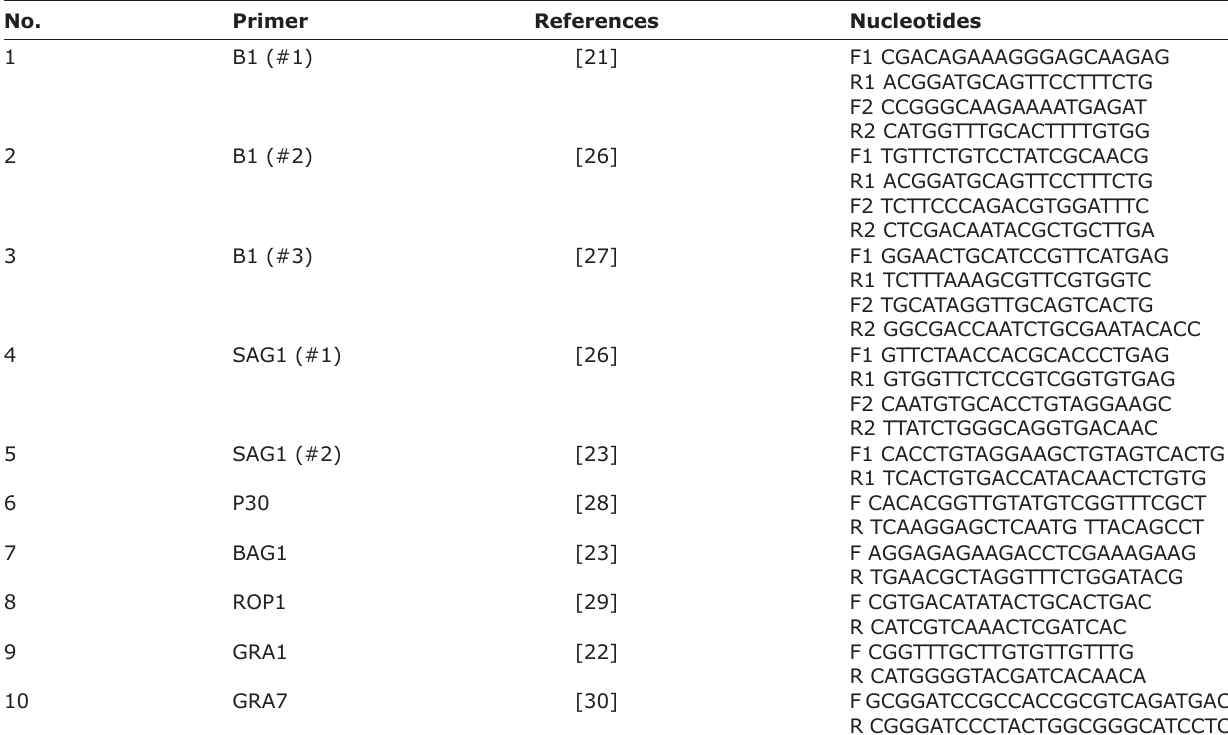
Table-1: The sets of Toxoplasma gondii gene primers.